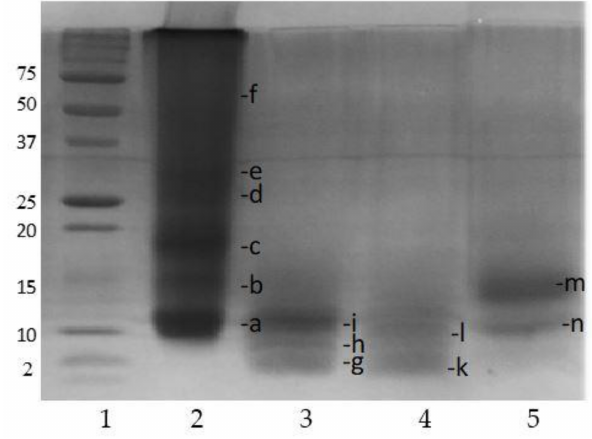
Figure 6. SDS-PAGE of protein isolate. Line 1: molecular weight marker; line 2: RPI; line 3: RPI (DH1); line 4: RPI (DH2); line 5: supernatant acidic (SA). The letters (a–n) represent the molecular weights (kDa) of each band in the extracts: a (10), b (15), c (18), d (25), e (30), f (50), g (2), h (5), i (10), k (2), l (8), m (15), n (10).